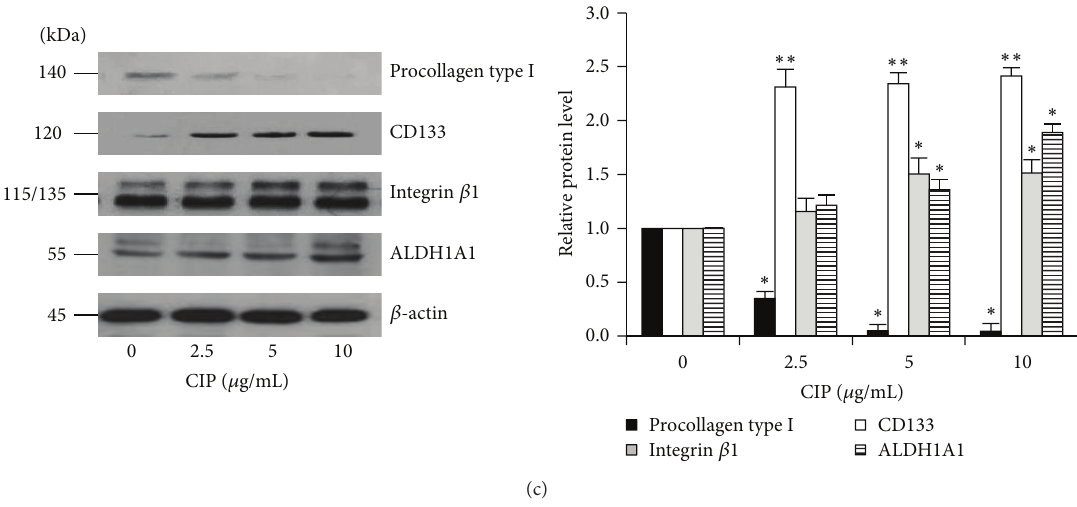
Figure3:EffectsofCIPonstemcellmarkersinDPCs.(a)CellswereculturedinthepresenceorabsenceofCIP(10 𝜇 g/mL)for72h.Thecellsat the early passages were used as an untreated control at 0h. Expression of CD133 and procollagen type I were analyzed by immunofluorescence staining. Scale bar is 50 𝜇 m. (b) Time-dependent effects of CIP treatment on the expression of stem cell markers were determined. Cells were cultured in the presence or absence of CIP (10 𝜇 g/mL) for 0–72 h. The levels of procollagen type I, CD133, integrin 𝛽 1, and ALDH1A1 were determined by western blot analysis. Blots were reprobed with 𝛽 -actin to confirm equal loading. The immunoblot signals were quantified by densitometry and the mean data from independent experiments were normalized to the results. The data represent the means of four independent samples ± SD. ∗ 𝑃 < 0.05 versus untreated control at 0h. (c) Cells were treated with CIP (0–10 𝜇 g/mL) for 72 h. After indicated treatment, levels of procollagen type I, CD133, integrin 𝛽 1, and ALDH1A1 were analyzed by western blot. 𝛽 -actin was served as the loading control. The immunoblot signals were quantified by densitometry and the mean data from independent experiments were normalized to the results. The data represent the means of four independent samples ± SD. ∗ 𝑃 < 0.05 and ∗∗ 𝑃 < 0.01 versus untreated